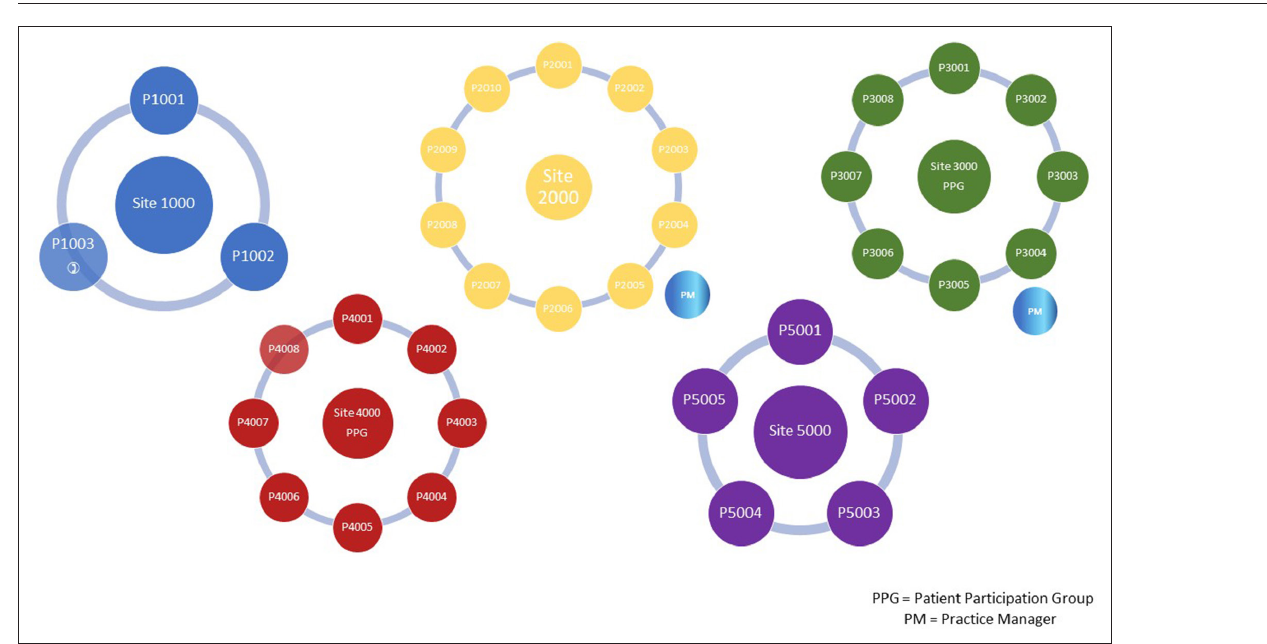
Figure 1 Distribution of patient focus groups. PPG = patient participation group. PM = practice